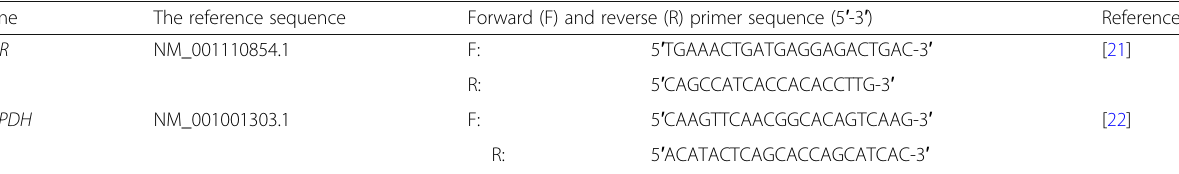
Table 1 Gene nomenclature, GenBank accession code, and primer sequences for Mus musculus (house mouse) gene expression analysis with qRT-PCR The reference sequence